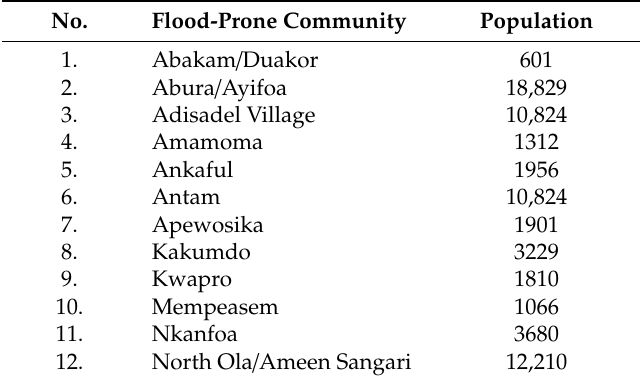
Table 3. Top 12 Flood-prone communities in the Cape Coast Metropolis in 2018. No. Flood-Prone Community